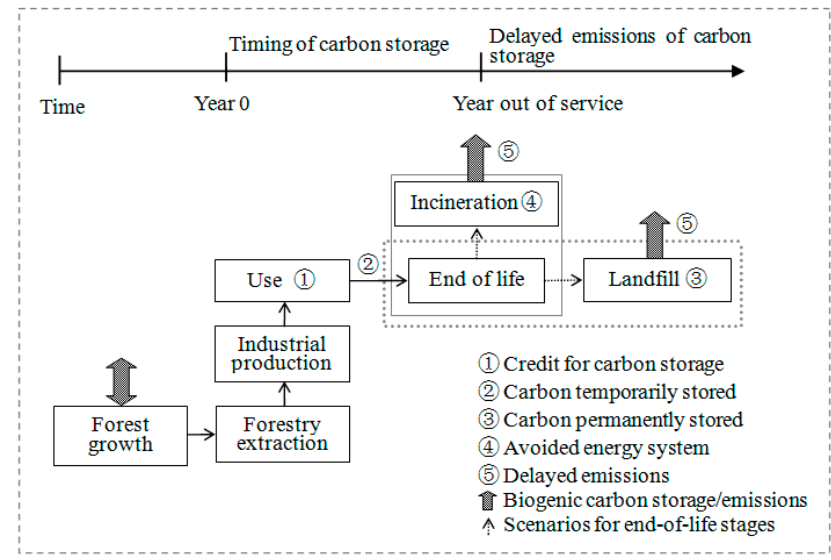
Figure 3. Carbon storage and delayed emissions for end-of-life treatment (incineration and landfill).